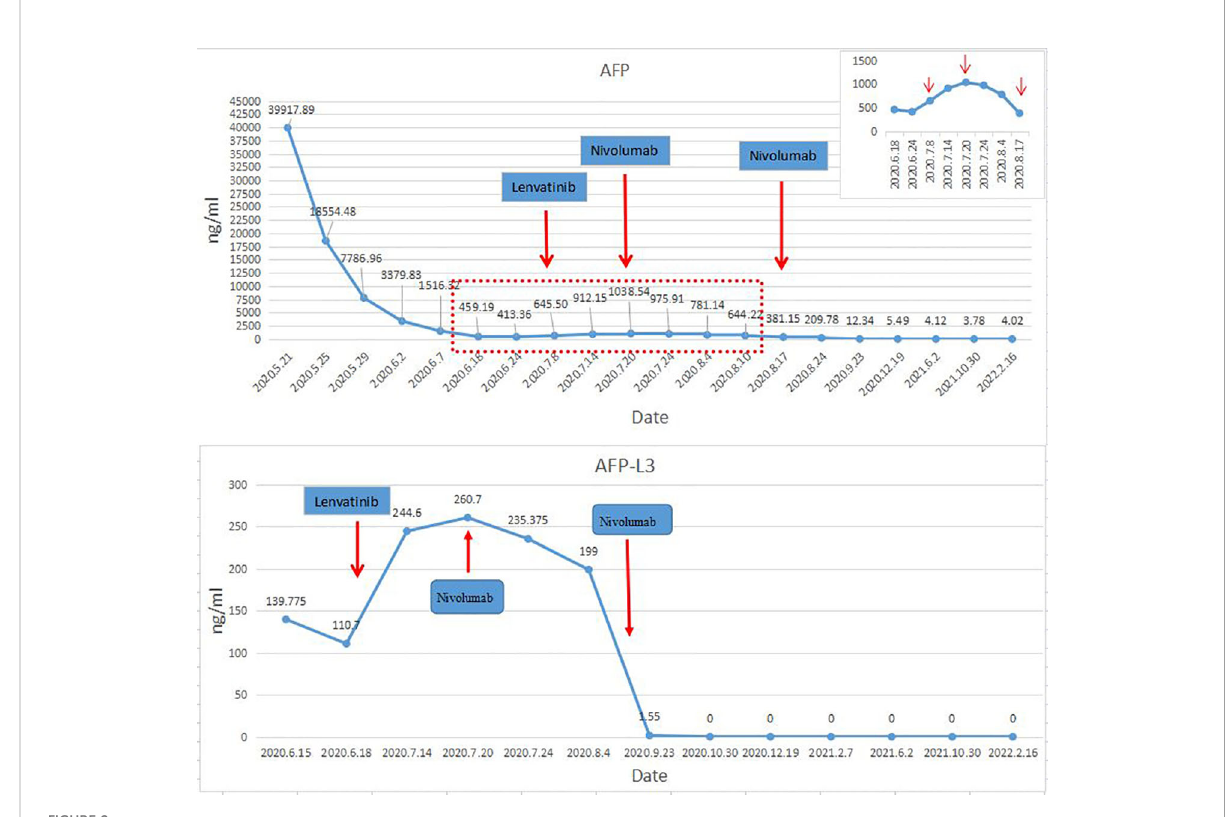
FIGURE 2 The trend chart of AFP and AFP-L3 after